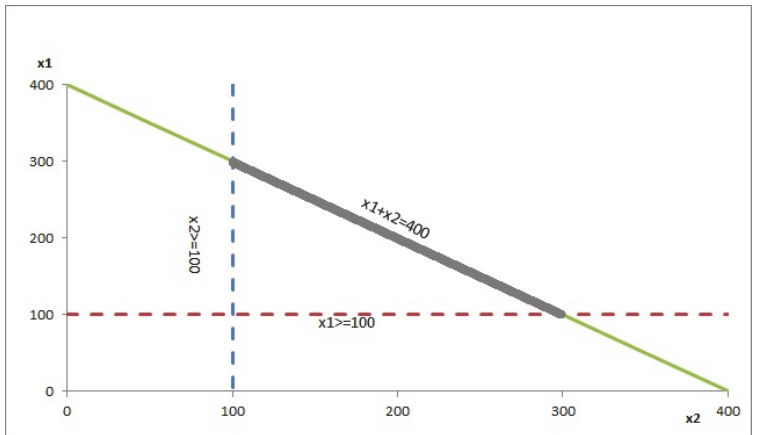
Fig. 5. Space of Core for two subcontractors